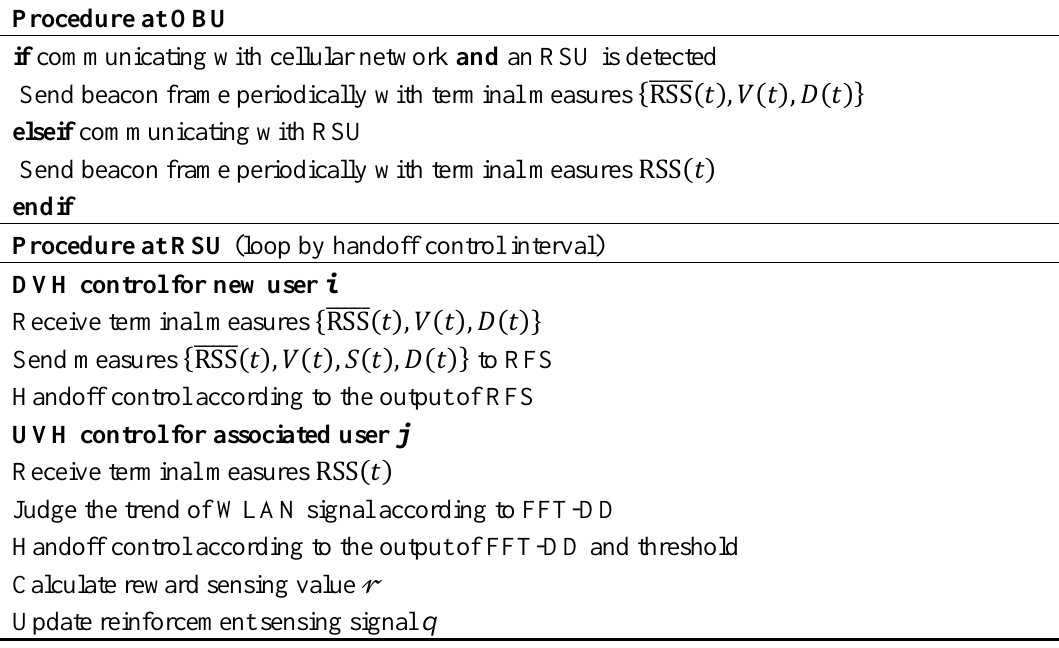
Table 1. Pseudo-code for the proposed handoff control